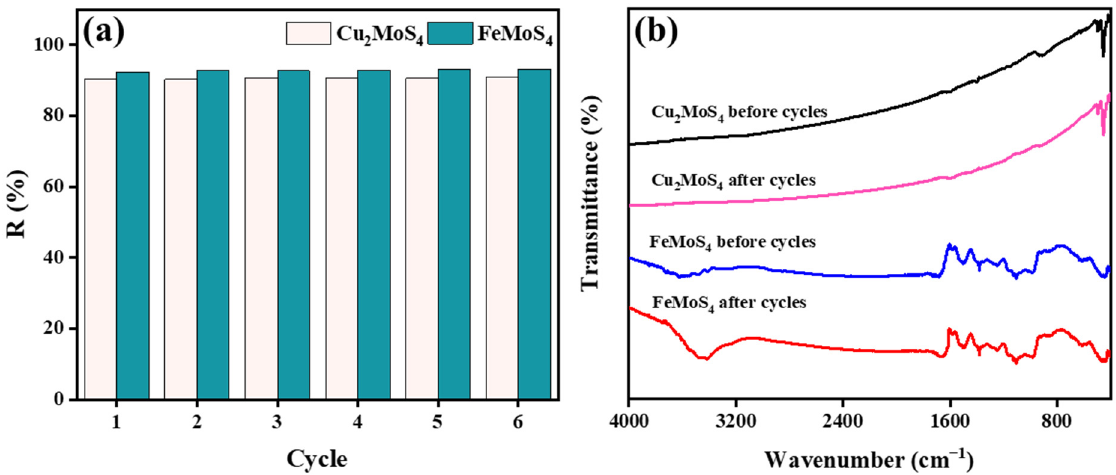
Figure 8. ( a ) Adsorption of regeneration performance and ( b ) FTIR spectra of Cu 2 MoS 4 , FeMoS 4 , Cu 2 MoS 4 , and FeMoS 4 after